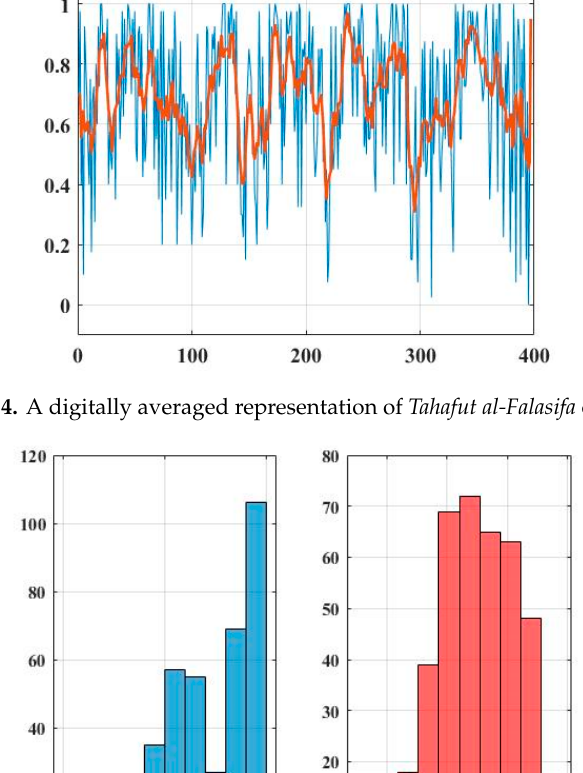
Figure 5. Histograms of the chunked scores of Tahafut al-Falasifa for the averaged profile (the left panel) and its smoothed version (the right panel).